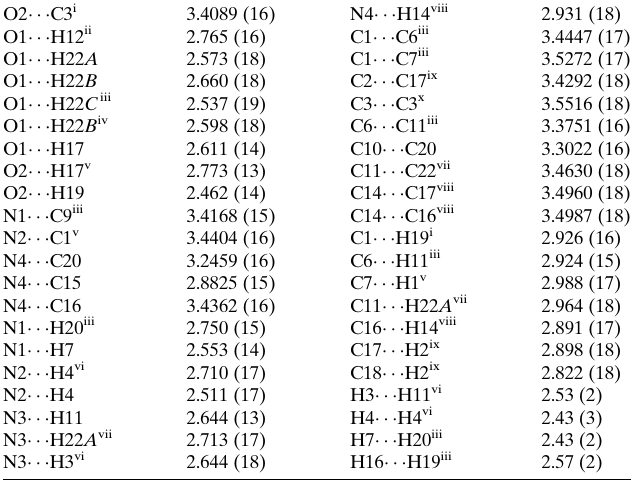
Table 2 Selected interatomic distances (A˚